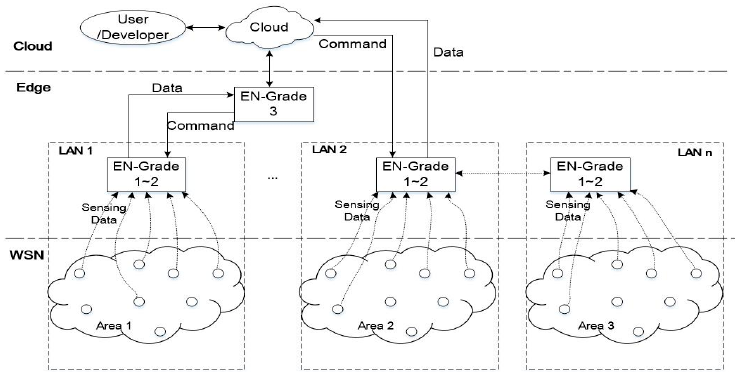
Figure 1. Edge-computing-based tiered system architecture. ‘EN’ indicates edge node. A smaller EN-Grade number indicates the physically closer location from the edge node to the sensor nodes and sensing devices.